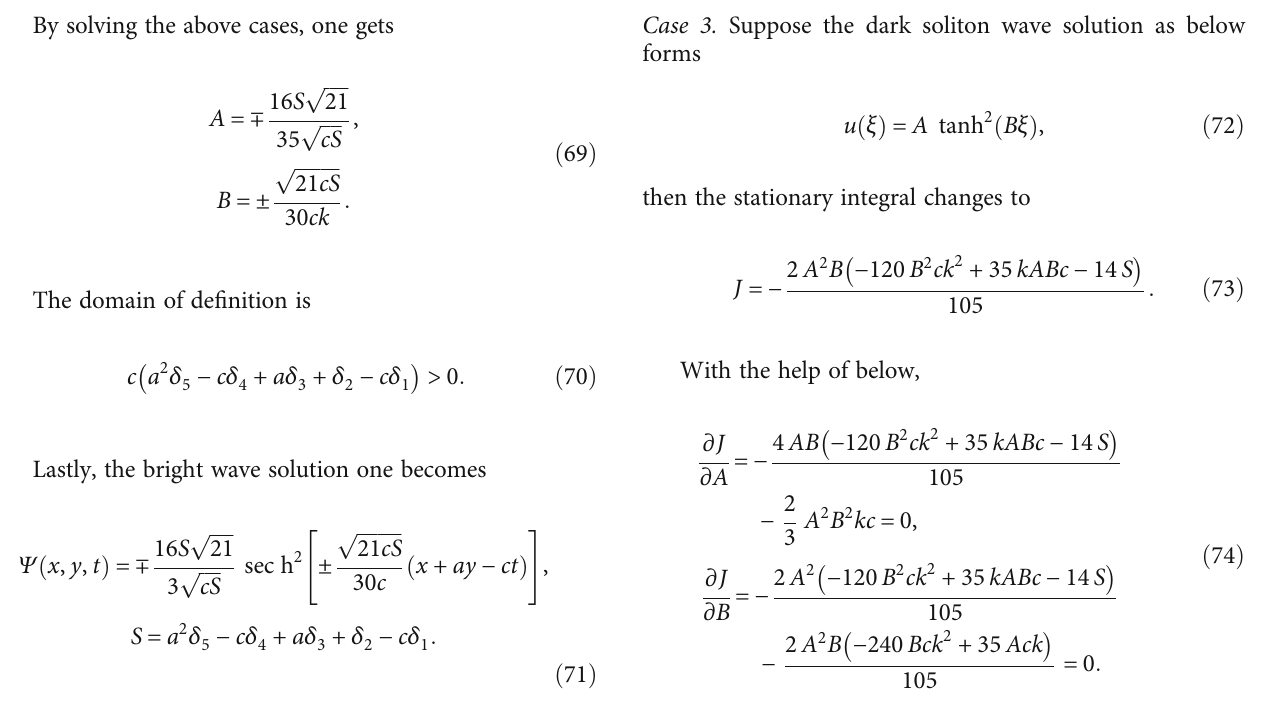
Figure 9: Plot evolution of cross-kink waves (39) utilizing values a = 2, δ = 1 : 3, δ = 2, Ψ = 1, t = 10 and (a) 3D plot, (b) density plot, and (c) contour δ 3 4 5 0